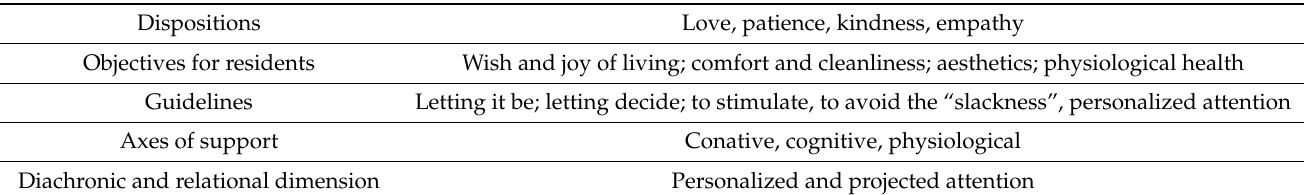
Table 4. The elements of the health care worker’s “own